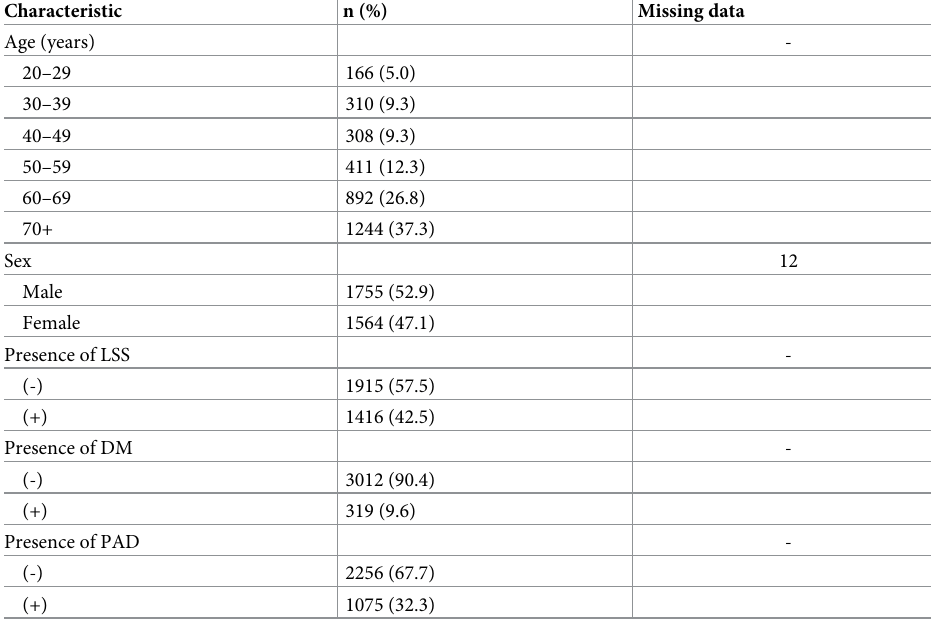
Table 3. Patient